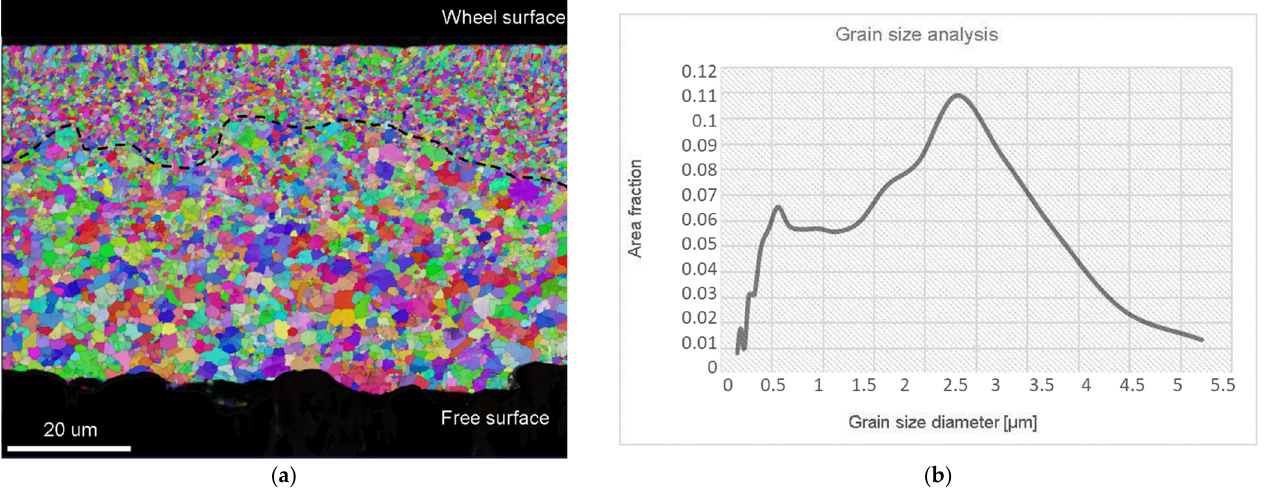
Figure 7. Grain size analysis of a transverse cross-section of the internally oxidised microstructure: ( a ) EBDS mapping at magnification 1500×; ( b ) graph of grains’ diameter vs. area fraction. Microchemical analysis was performed throughout the microstructure of the internally oxidised ribbons. Both the line microchemical analysis shown in Figure 8 and the chemical mapping shown in Figure 9 confirm the lanthanum oxide particles.